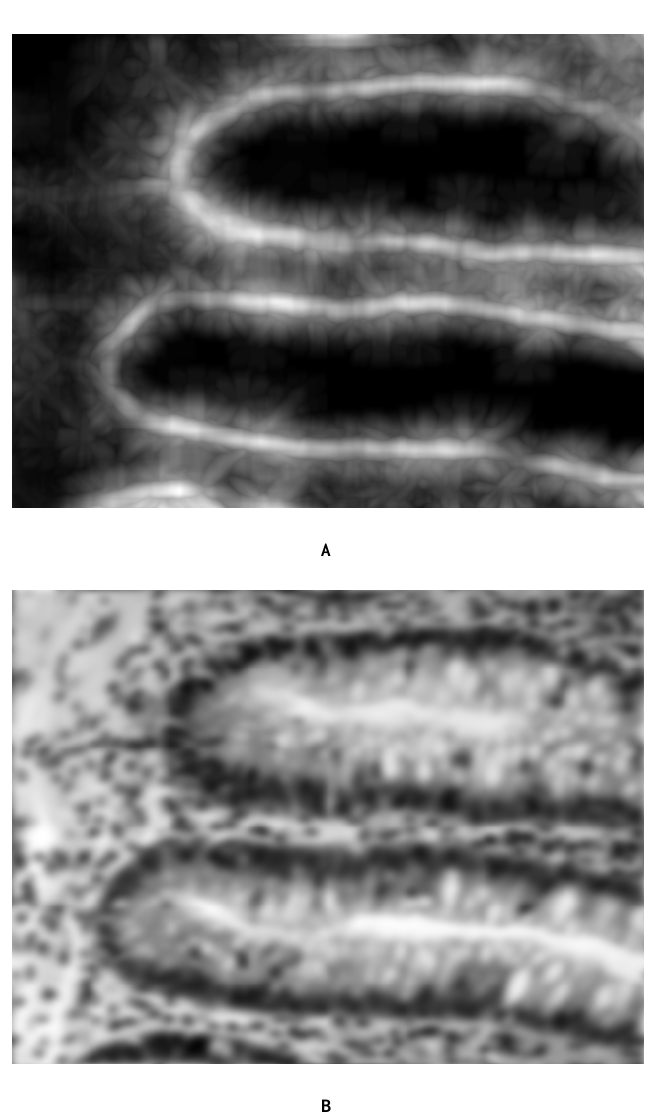
B FIGURE 10. (A) The ratio image by selecting the largest value among the four ratios of black pixels covered by the respective moving windows to the total number of pixels in the windows; (B) Gaussian filtering; (C) the combined segmentation by summing up all the black pixels in the four images in Figs. 9 (A–D); and (F) thresholding segmentation of Gaussian filtering in